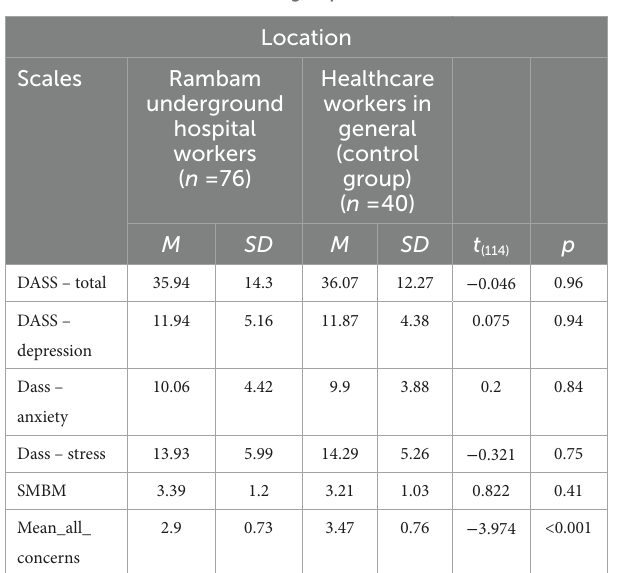
TABLE 1 Demographic characteristics of the study sample. TABLE 2 Differences in DASS, SMBM, and COVID-19 concerns (Mean_all_ concerns) scores between the two